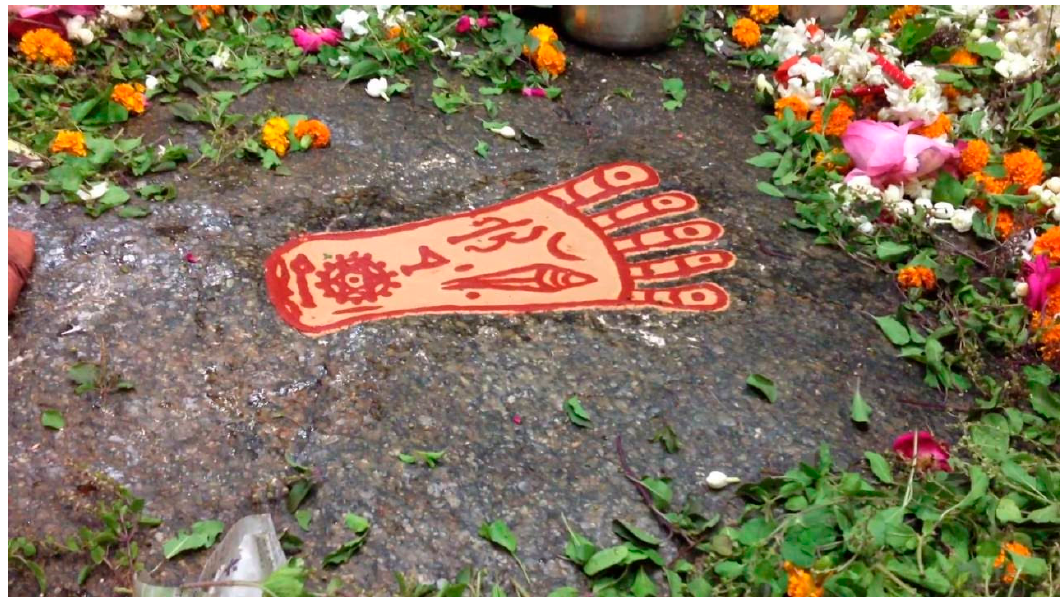
Figure 2. Gay ā —the footprint decorated for evening worship (Albertina Nugteren). Figure 2. Gay¯a—the footprint decorated for evening worship (Albertina